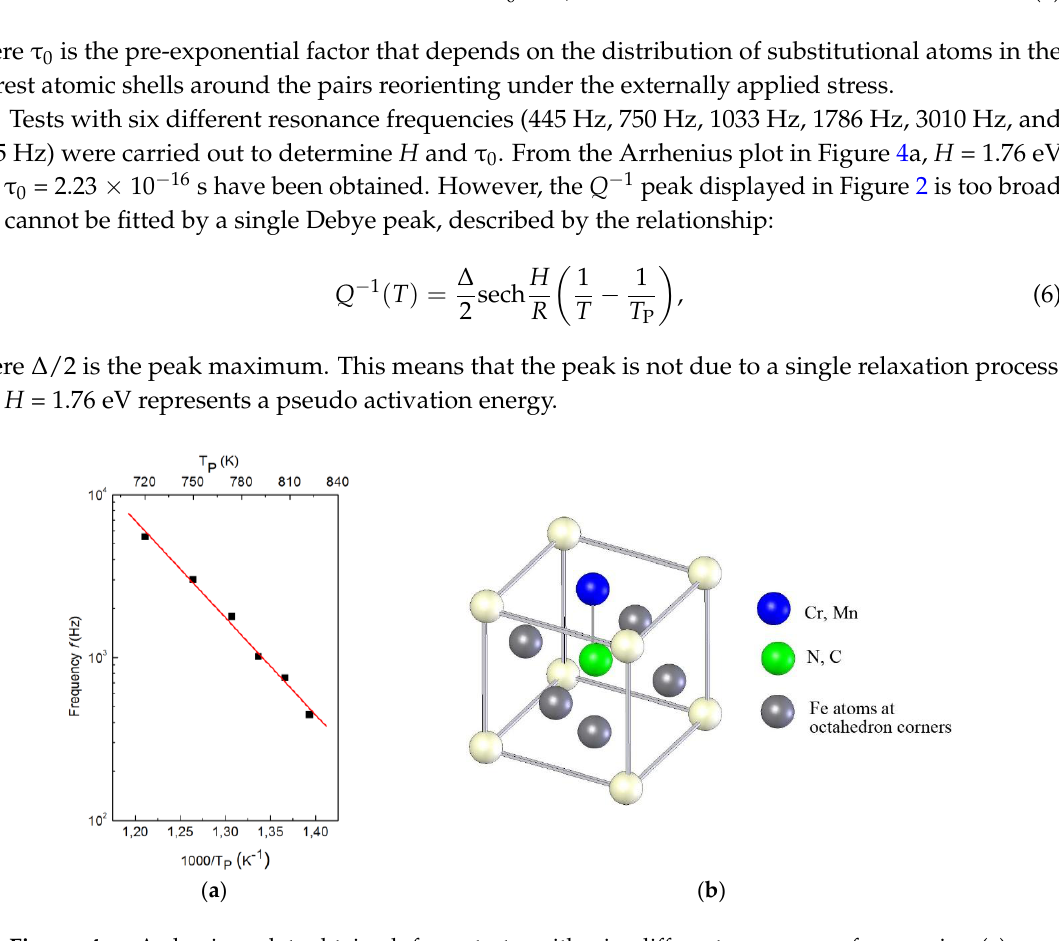
Figure 4. Arrhenius plot obtained from tests with six different resonance frequencies ( a ). Interstitial-substitutional (i-s) pairs in an fcc lattice of High Nitrogen Steel (HNS) ( b ).